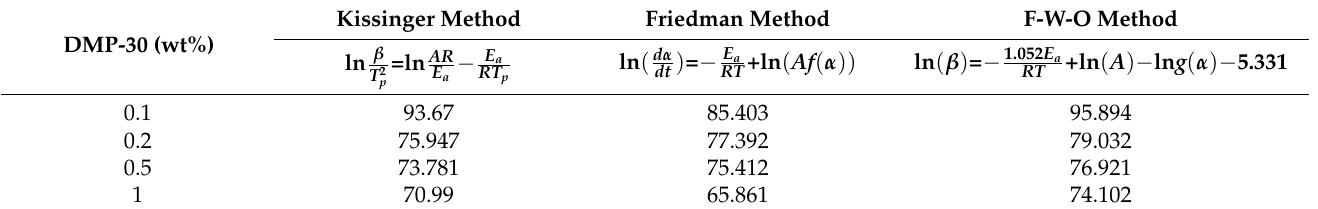
Table 2. Reaction activation energies of DEBGA/MHHPA system with various DMP-30 contents